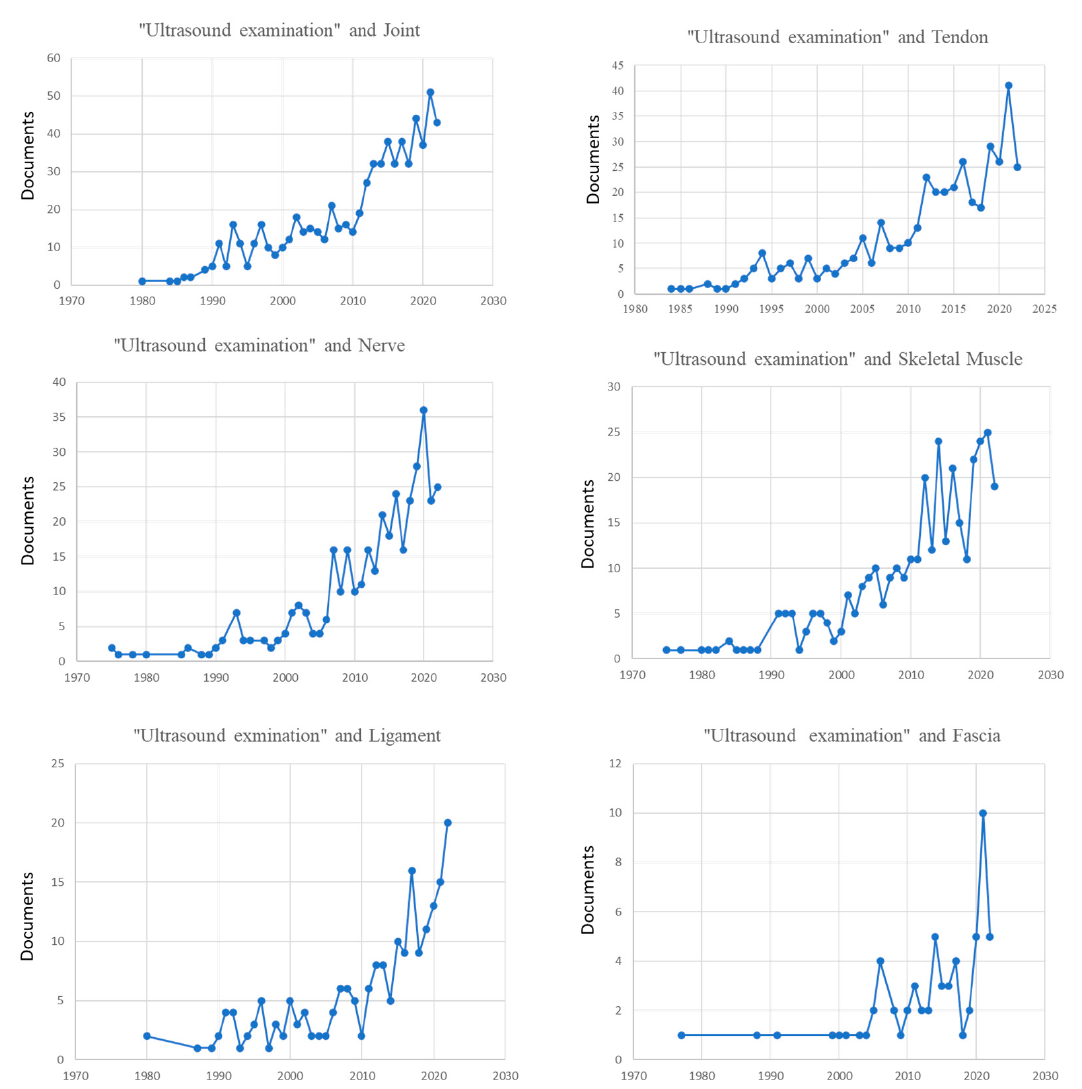
Figure 2. Number of papers published on ultrasound examination and different structures of the musculoskeletal system.